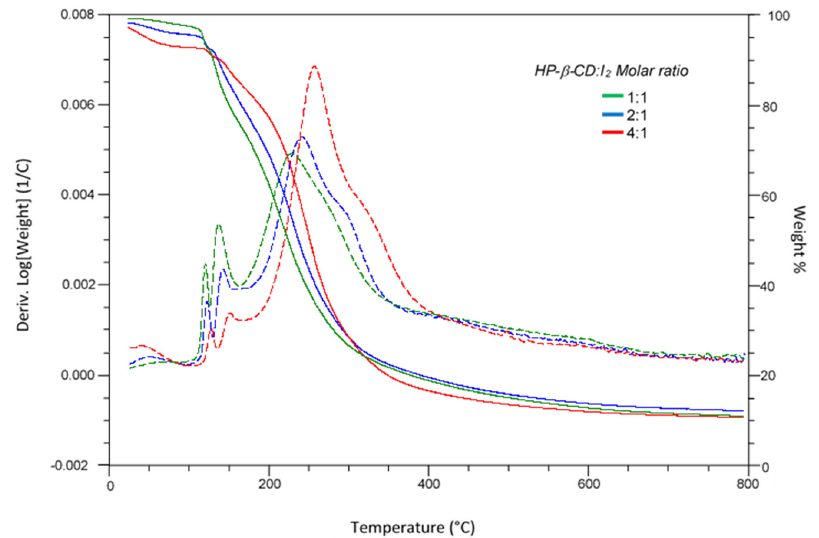
Figure 2. TG (solid lines) and first derivative (dotted lines) curves of HP- β -CD/I 2 complexes prepared by SH method in 1:1, 2:1 and 4:1 HP- β -CD:I 2 molar